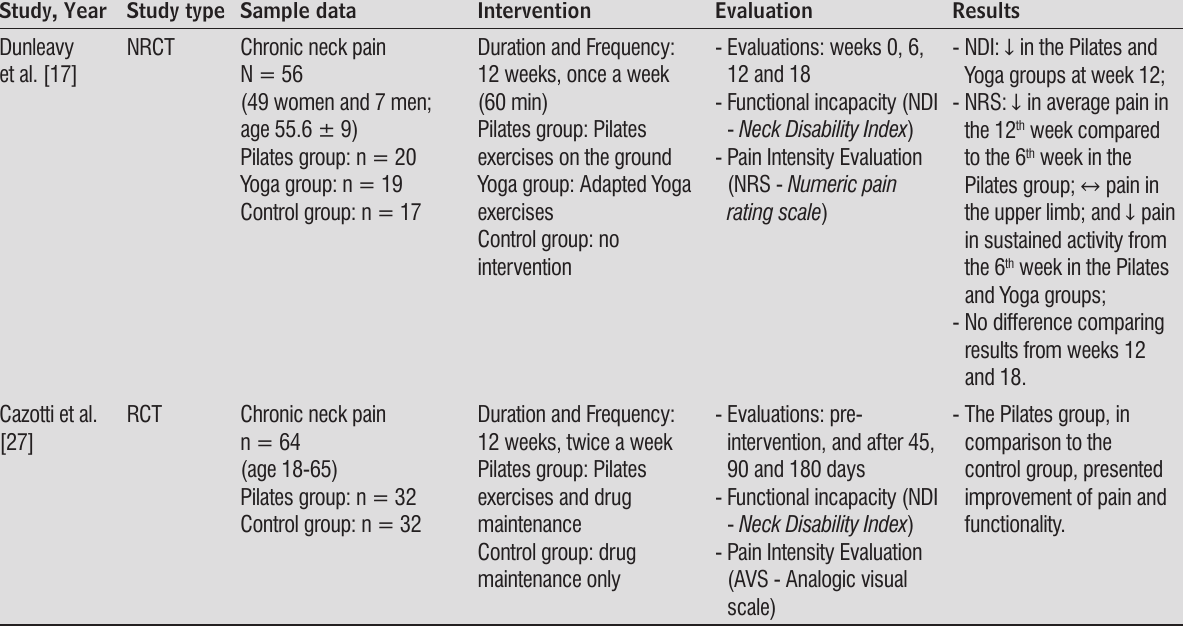
Table 2 - Characteristics of the included studies Study, Year Study type Sample data Intervention Evaluation